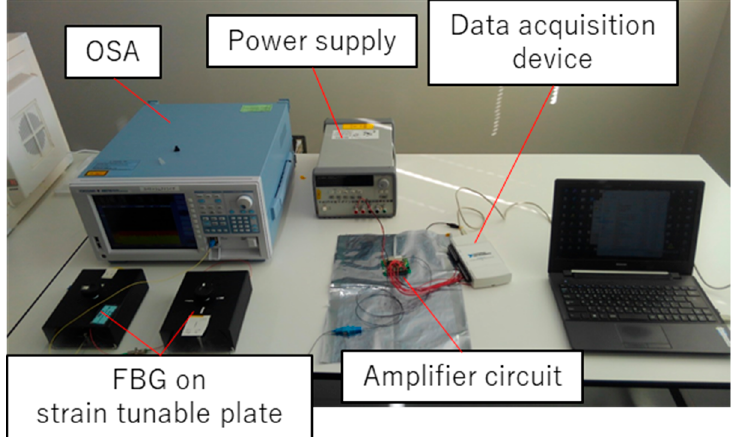
Figure 6. The measurement setup of the experiment to obtain the coefficient of the normalized differential to wavelength conversion formula, with 1543- and 1561-nm-centered FBGs glued separately on a steel plate, with the strain is controlled manually. The transmitted light of the FBGs is measured using an OSA, on which the Bragg wavelengths are calculated.